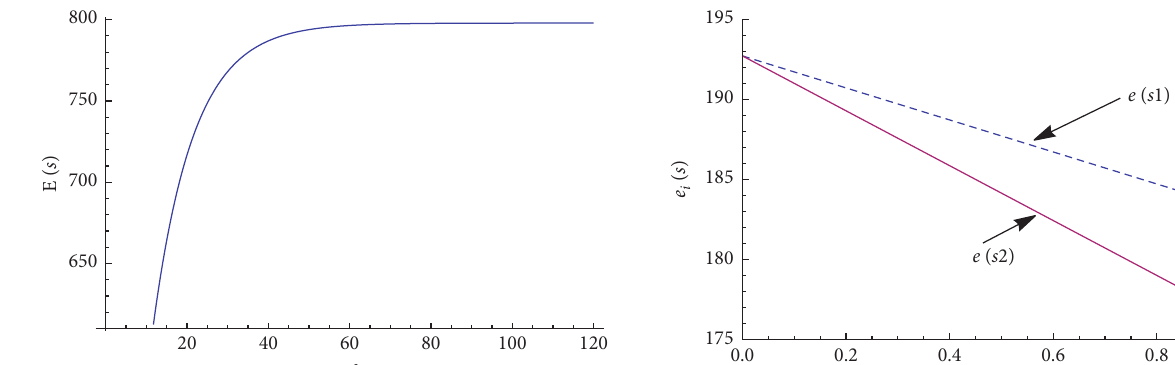
Figure 1: The dynamic evolution of environmental quality E ( s ) .